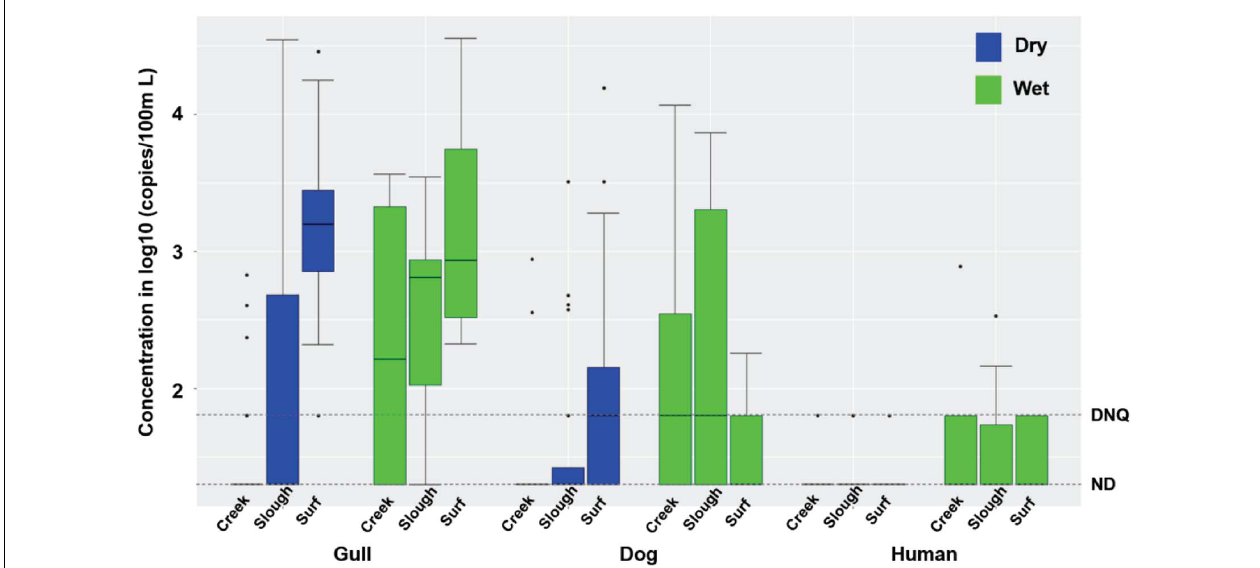
FIGURE 2 | Boxplots of gull, dog and HF183 human fecal marker concentrations in creek, slough, and surf zone (from left to right) water samples collected from watershed and surf zones of GB in 2016 and 2017 during dry and wet weathers ( Supplementary Tables 1, 2 ). The number of creek, slough, and surf zone samples was 40, 40, and 90 during dry wet weather, respectively, and 9, 7, and 9 during wet weather, respectively. DNQ (1.8 on log10 scale) and ND (1.3 on log10 scale) levels were shown in the figure as dotted